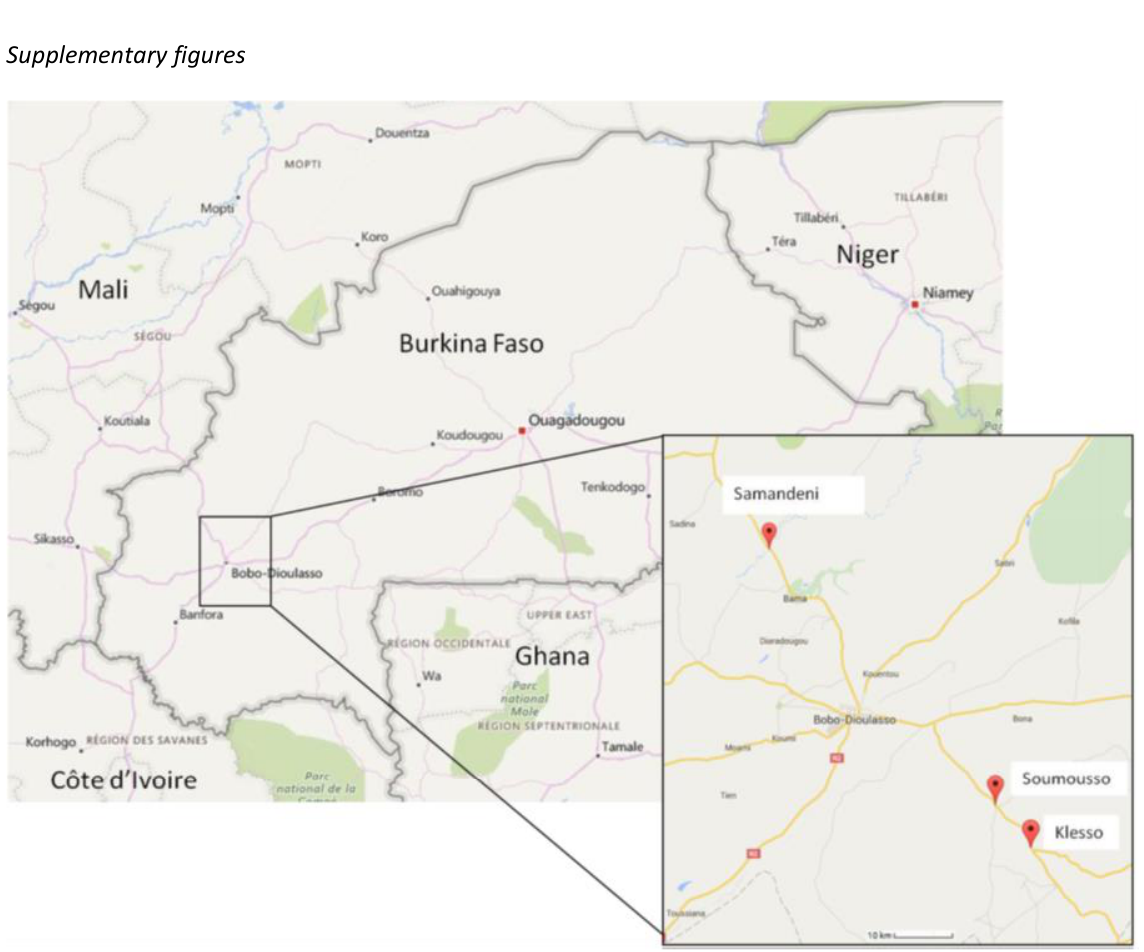
Figure S1. Study collection sites: Soumousso (11°23’14”N, 4°24’42”W), Klesso (10°56’40.5”N, 3°59’09.9”W), Samendeni (11°27’14.3”N,